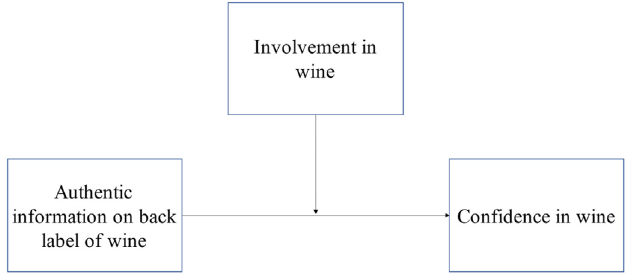
Fig. 1. Conceptual framework of H1 and